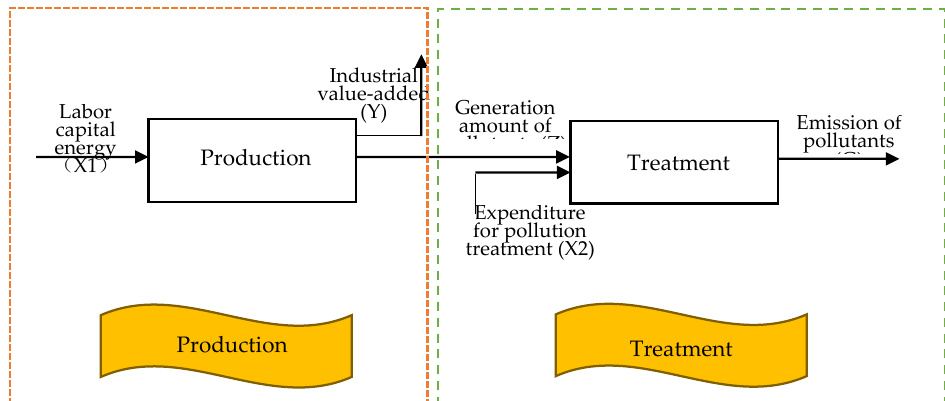
Figure 2. Two-stage structure of industrial system.